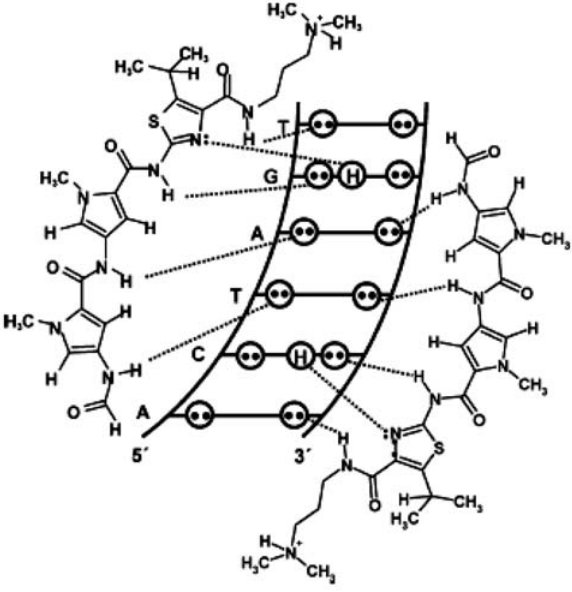
Figure 3. Expected arrangement of hydrogen bonding between 1 and the DNA duplex d(CGACTAGTCG)2, 2 (reprinted with per- mission from J. Am. Chem. Soc. , 2004 , 126 , 11338. Copyright 2004 American Chemical